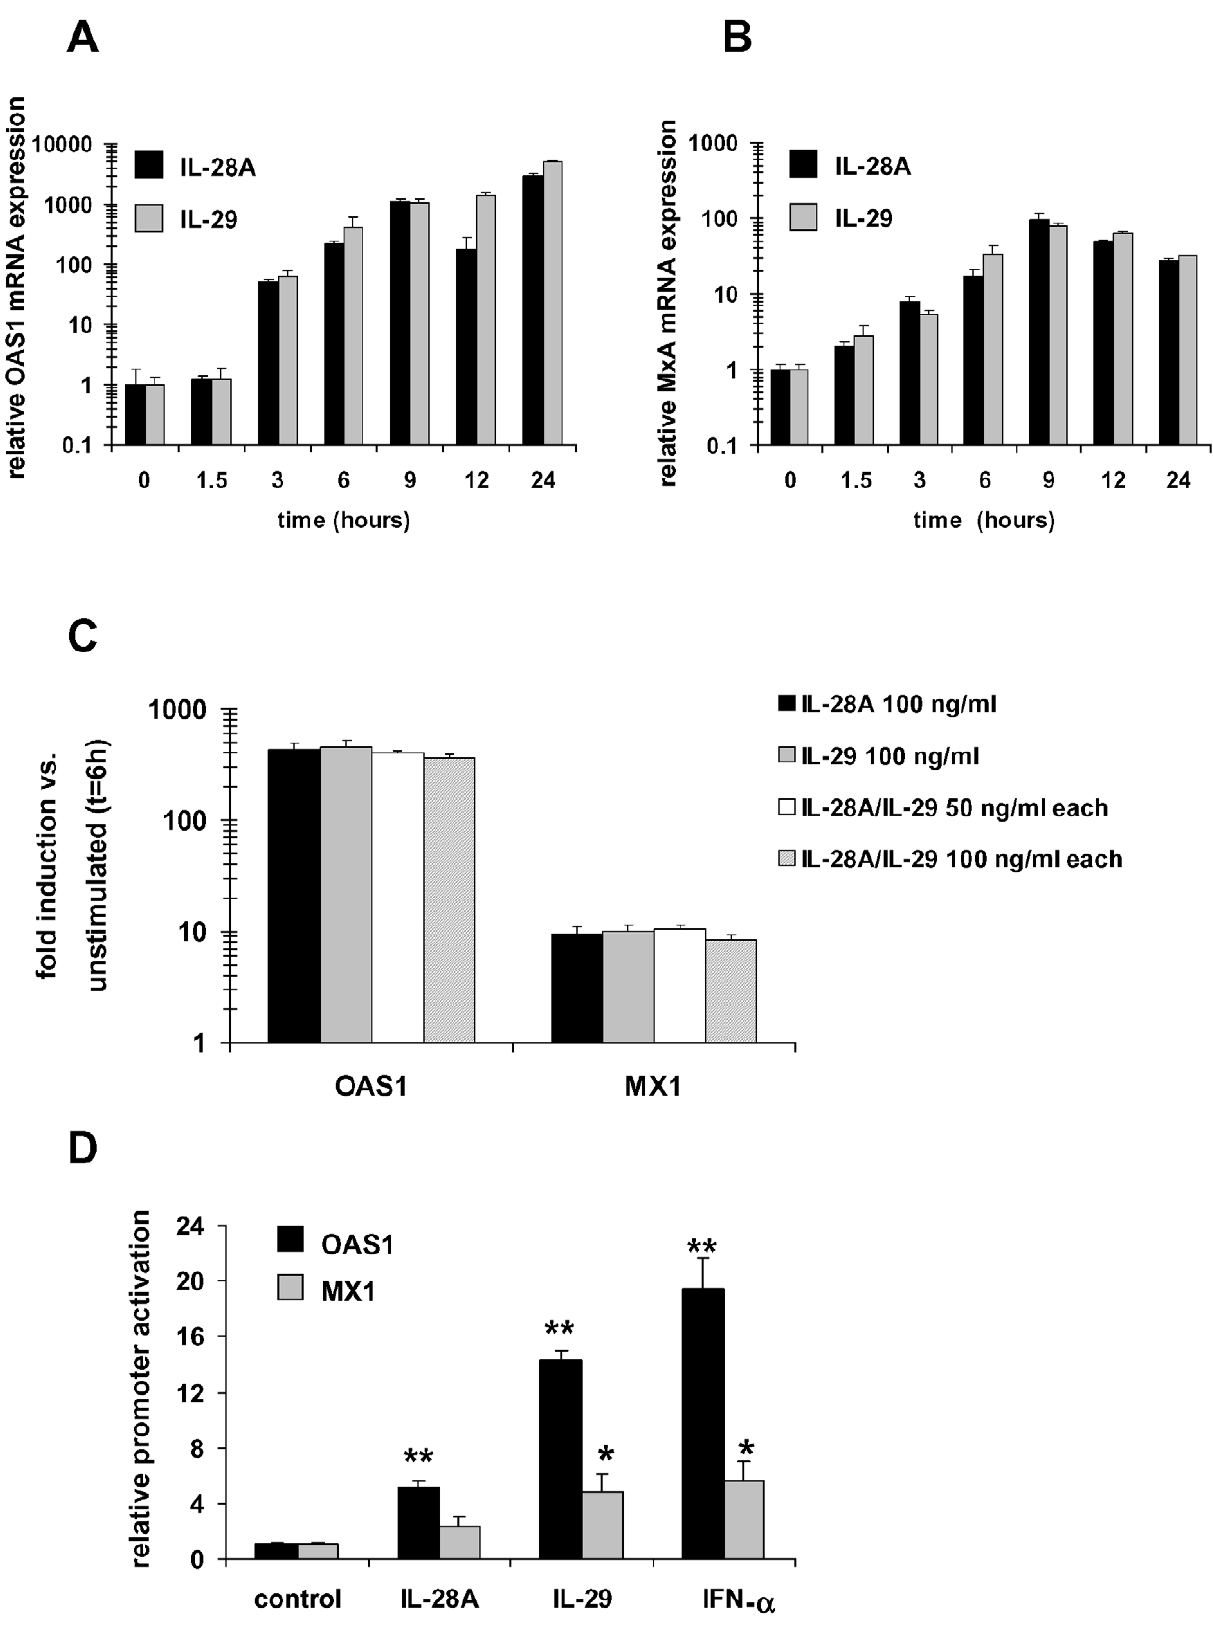
Figure 3. IL-28A and IL-29 induce OAS1 and MX1 mRNA expression and promoter activity in hepatic cells. (A) OAS1 mRNA expression is increased by IL-28A and IL-29 stimulation of Huh-7 cells reaching maximal levels after 24 hours. Samples were analyzed by quantitative PCR in triplicate for each group and were normalized to the expression in unstimulated cells. (B) IL-28A and IL-29 induce maximal MX1 mRNA expression